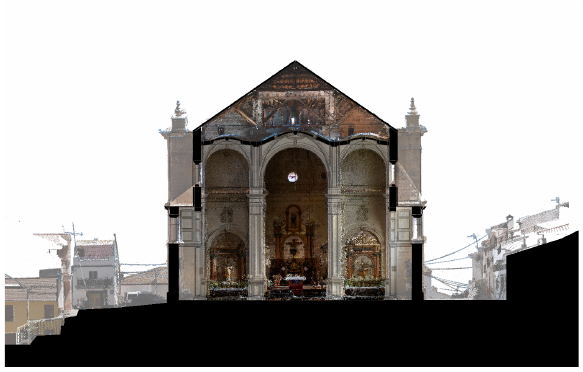
Figure 9. 3D model cross-section with solid fill and point